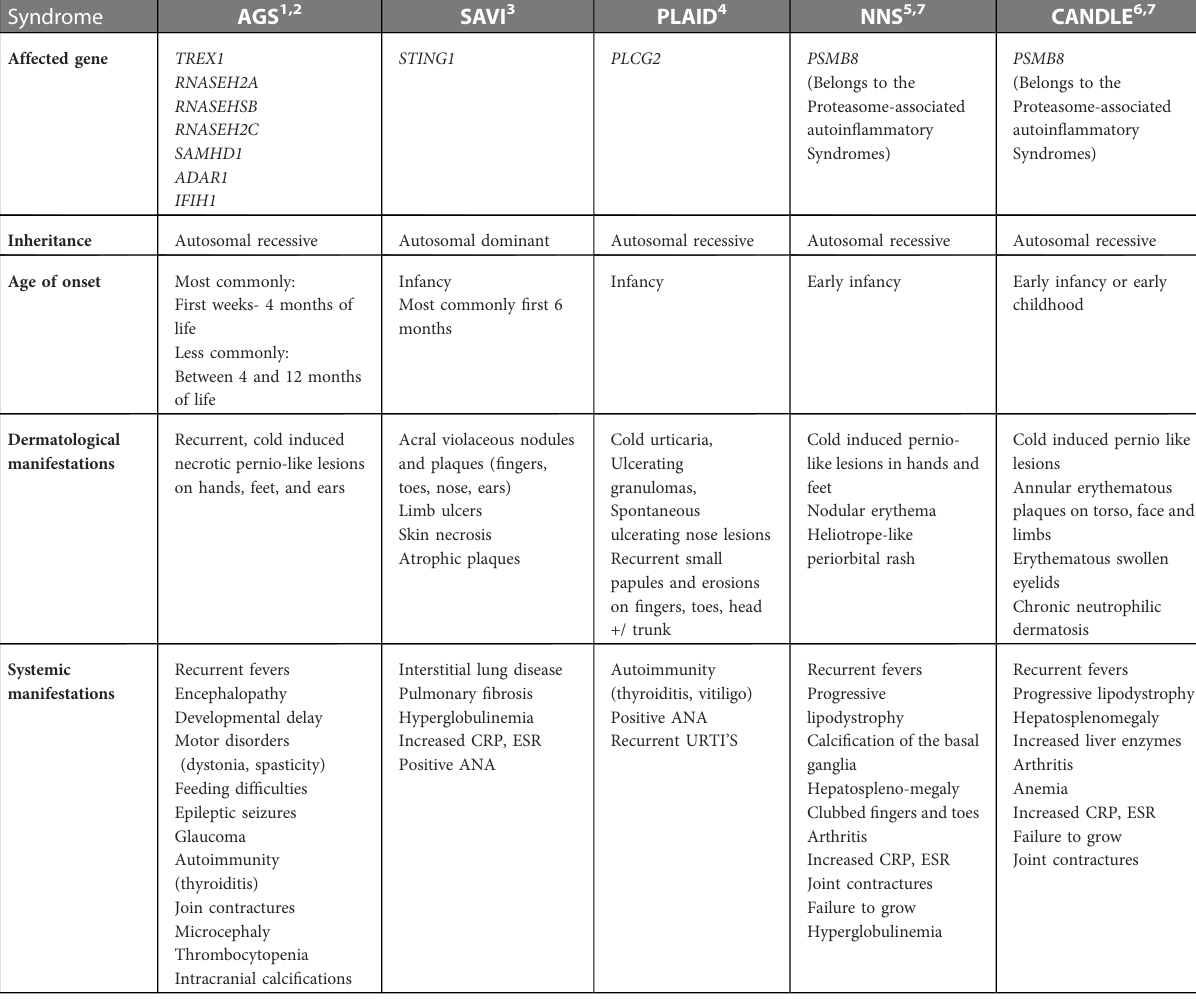
TABLE 1 Characteristics of type I interferonopathies included in our differential